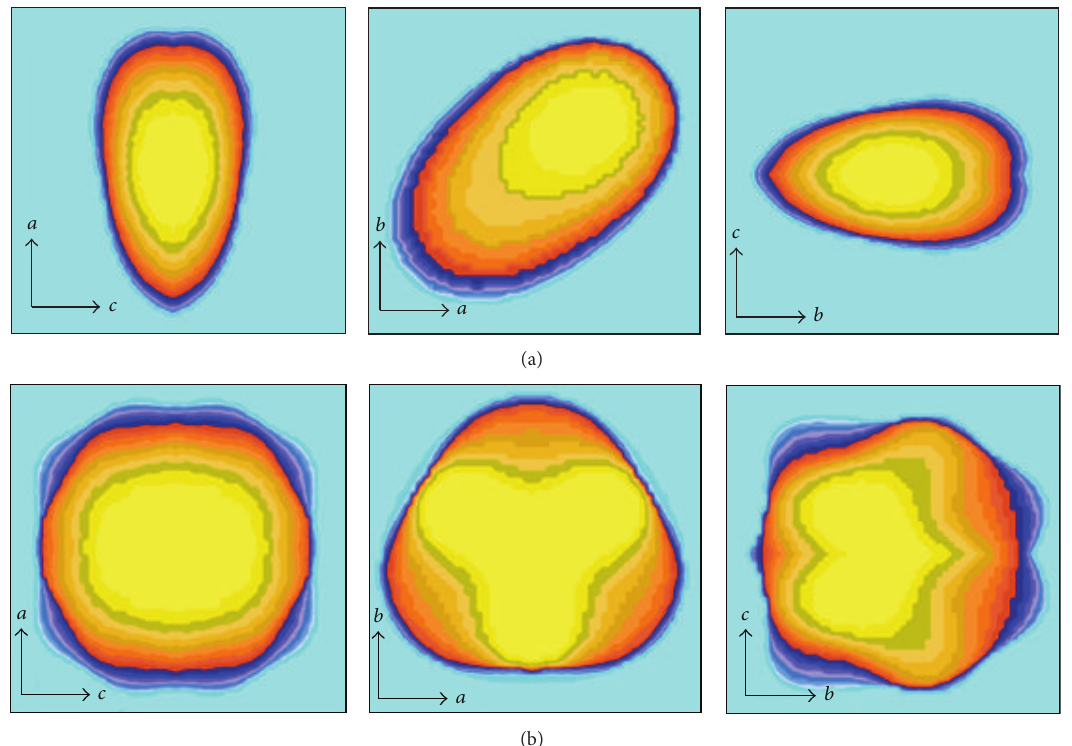
Figure 8: Crystallite shapes for (a) PANI-ES and (b) 𝛼 -Al 2 O 3